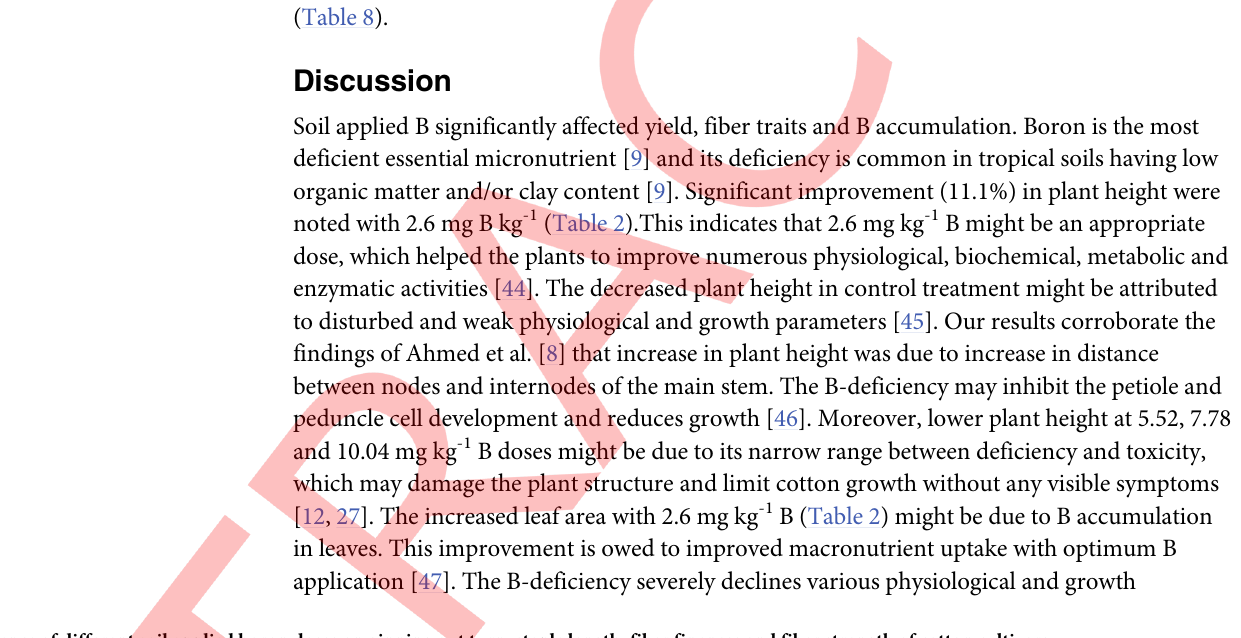
Table 8. Influence of different soil applied boron doses on ginning out turn, staple length, fiber fineness and fiber strength of cotton cultivars. B doses(mg kg -1